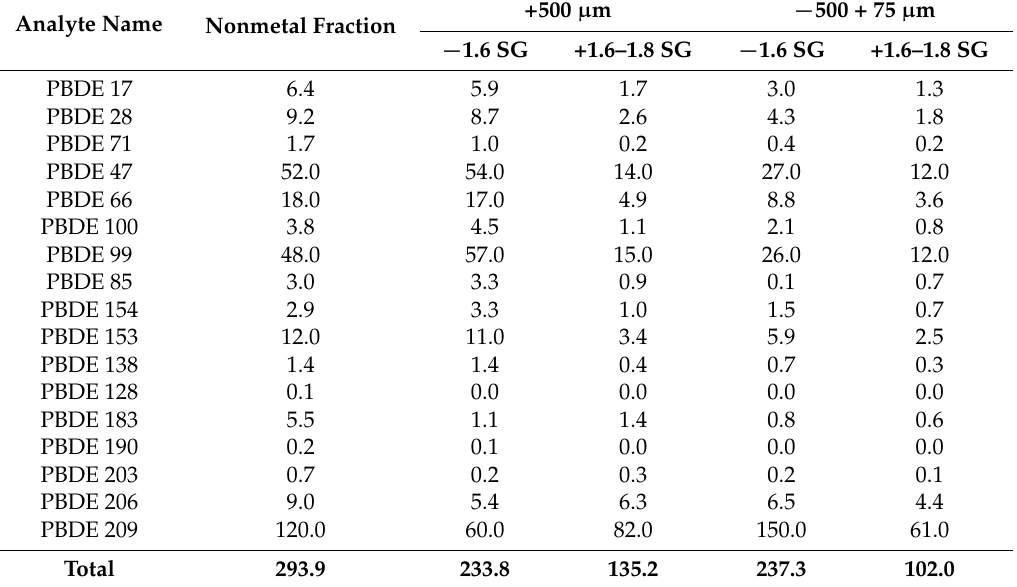
Table 3. Concentration of various congeners of PBDE in analyzed samples in mg/kg.